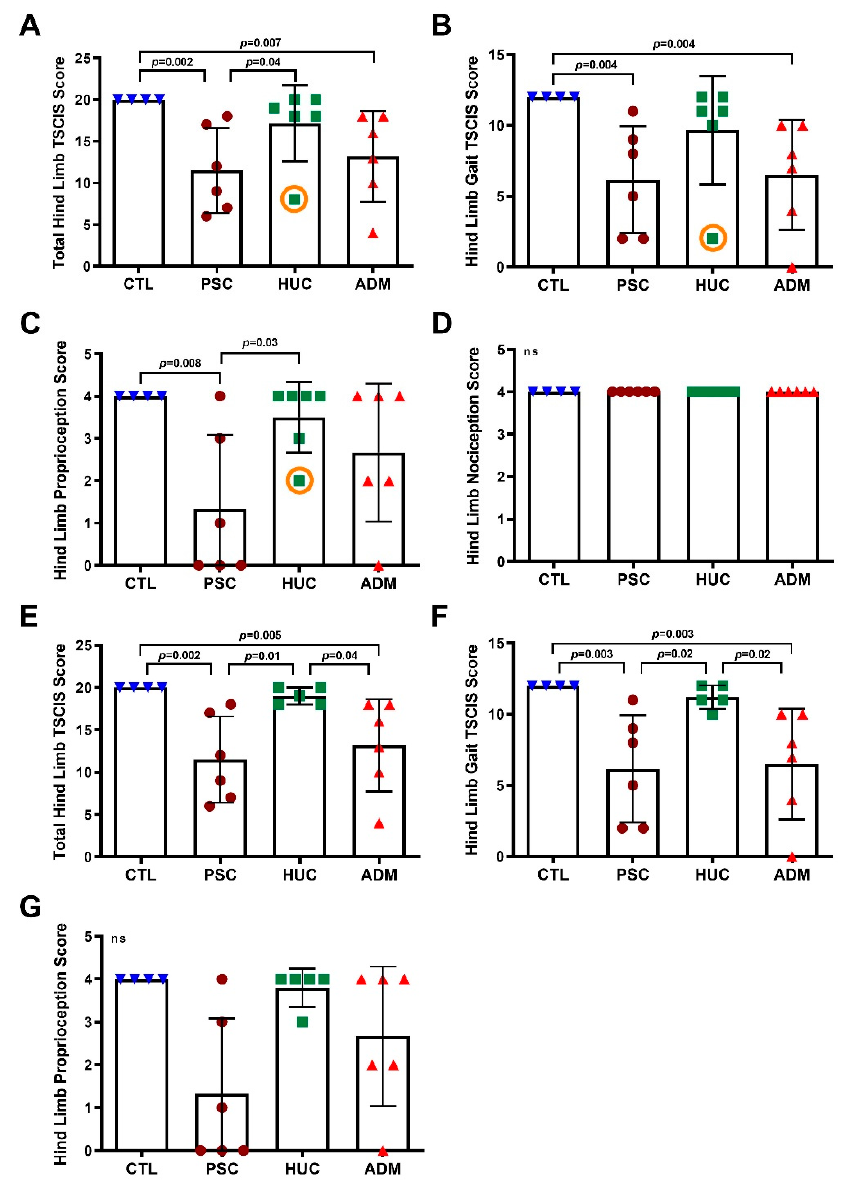
Figure 2. Texas Spinal Cord Injury Scale (TSCIS) scores of spina bifida defect repaired lambs. TSCIS scores for control lambs and the three SB surgical repair groups are provided. Graphs ( A ) through ( D ) include data from a lamb that was repaired with a HUC patch observed to have the lowest score, which was later found to have had a fresh hemorrhage on MRI and histology, whereas Graphs ( E ) through ( G ) does not. ( A ) Total TSCIS scores for control (CTL), PSC, HUC, and ADM repaired groups are given. ( B ) Hind limb gait TSCIS scores for CTL and repair groups are shown, with those being the three surgically repaired groups. ( C ) Analysis of hind limb TSCIS proprioception scores. ( D ) Hind Limb nociception for all evaluable lambs in the study are provided. ( E ) Post hoc analysis of total TSCIS scores between all repair and control groups with the aforementioned HUC outlier removed. ( F ) Post hoc analysis of hind limb gait TSCIS scores between all repair and control groups with the HUC lamb having the lowest score, as described, removed. ( G ) Post hoc analysis of hind limb proprioception TSCIS scores between all repair and control groups with the HUC lamb having the lowest score, as described, removed. Data are shown as mean ± s.d. p -values were determined by ANOVA, Kruskal–Wallis test, Two- stage linear step-up procedure of Benjamini, Krieger, and Yekutieli, whereby p < 0.05 were considered significant and ns represents non-significant ( p > 0.05) data.